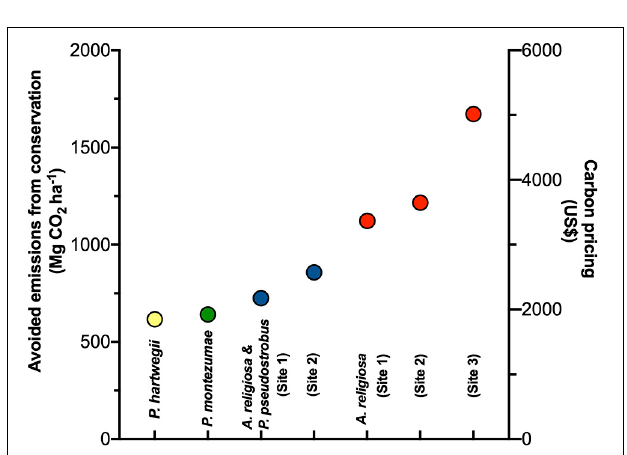
FIGURE 4 | Estimates of avoided CO 2 emissions from conservation of forests and the value for forest conservation in $US assuming every Mg CO 2 is worth US$